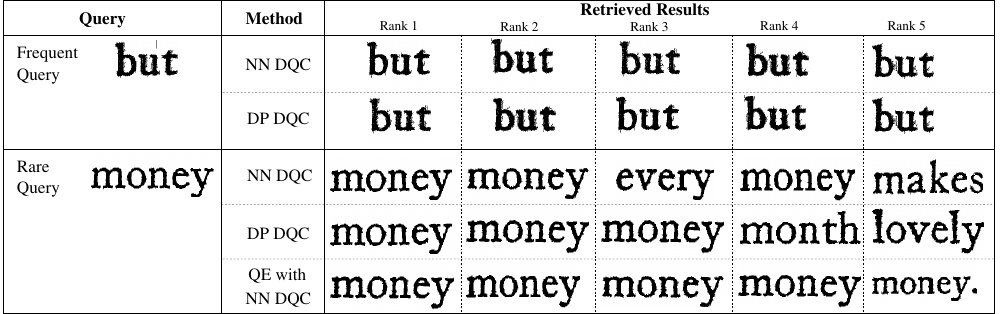
Figure 1. Figure shows few query words and their corresponding retrieval results. The first column shows the query image and the corresponding images in each row are its retrieval results. First two rows show frequent query results. The first row shows the results for NN DQC and second row show the results for DP DQC. Row 3 to Row 5 show the retrieval results for a rare query. Row 3 shows the results for NN DQC and Row 4 show the results for DP DQC and Row 5 show the results for query